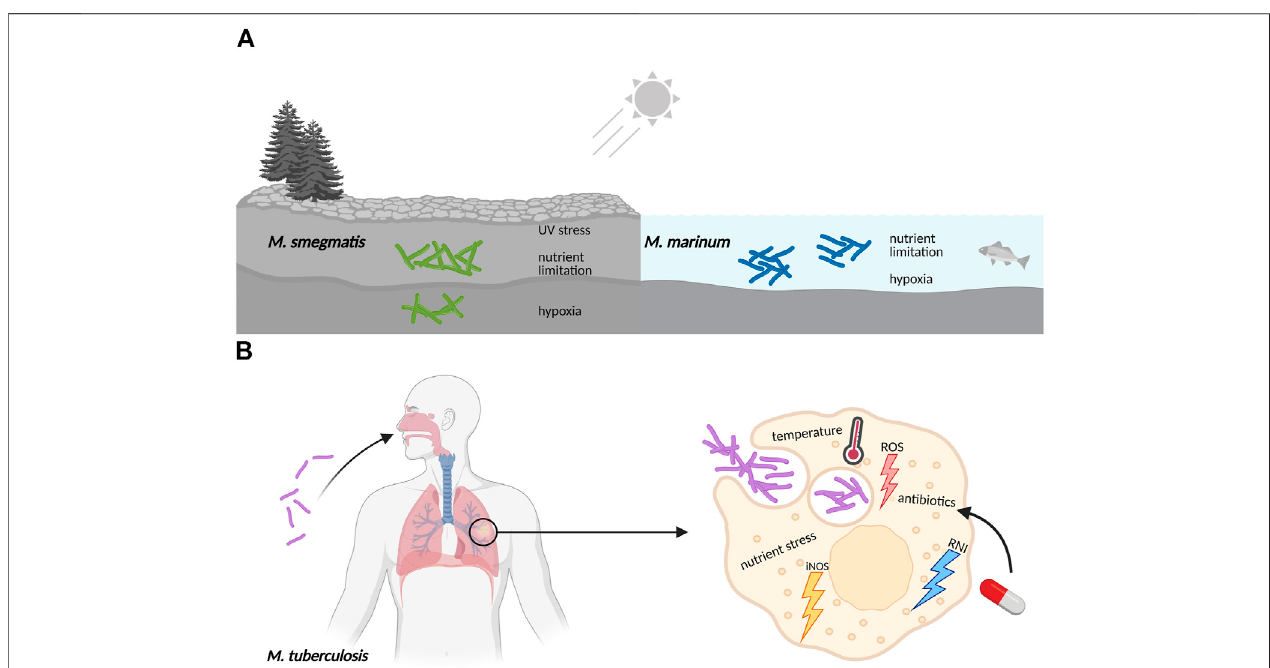
FIGURE 1 | Mycobacteria frequently encounter adverse conditions in their natural surroundings, requiring coordinated stress responses. (A) Free living mycobacteria,likethesoil-dwelling M.smegmatis ortheoceanbacterium M.marinum ,areexposedtoUVradiation,experiencesuddenchangesintemperature,haveto adjusttovaryingoxygenlevels,andneedtosurviveperiodsoflimitationinessentialnutrientslikecarbon,nitrogenandironminerals. (B) Pathogenicmycobacterialike M. tuberculosis are exposed to hostile environments when growing inside host macrophages, where they also face sudden changes in nutrient availability, pH and temperature. The defensive mechanisms of macrophages include the production of reactive oxygen species (ROS), nitric oxide synthase in its inducible isoform (iNOS), and reactive nitrogen intermediates (RNI). Furthermore, exposure to antibiotics during drug treatment of M. tuberculosis infections also elicits stress responses in an attempt to evade killing and develop